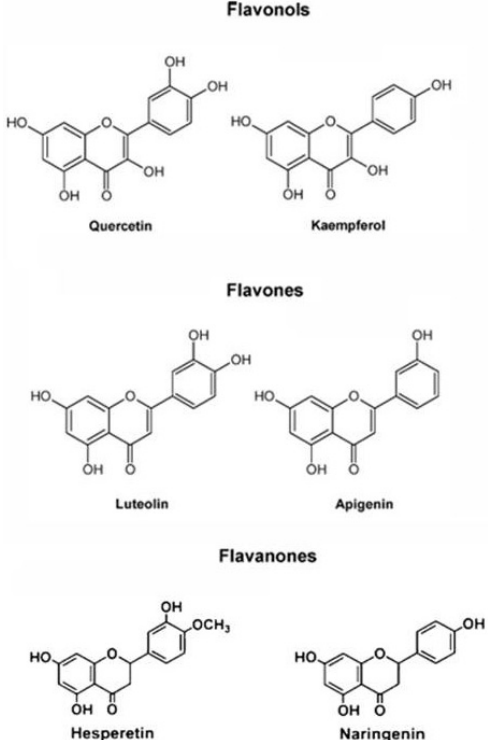
Figure 4. Structures of flavonoids showing differences in B-ring hydroxylation within subclasses.